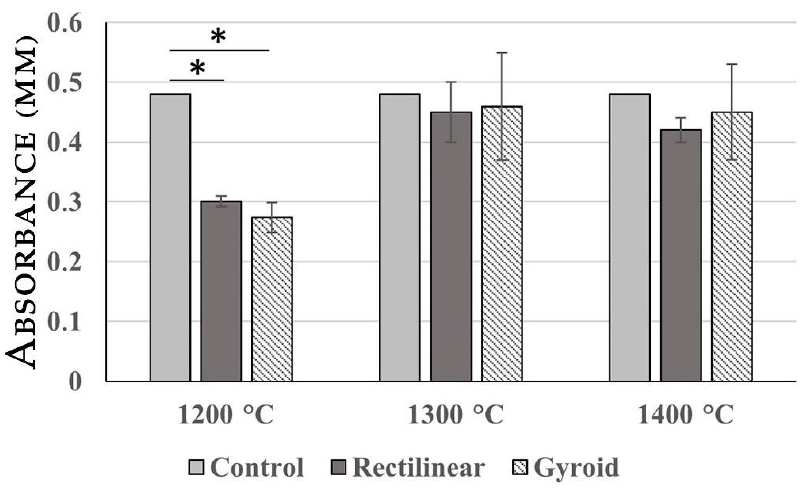
Figure 2. Results of MTT assay. The analyzed scaffolds processed at 1300 °C and 1400 °C were non-toxic. Only in the case of scaffolds processed at 1200 °C did we record a significant inhibitory effect when compared with the control. Asterisk (*) represents Extreme outlier which is an observation that lies an abnormal distance from other values.